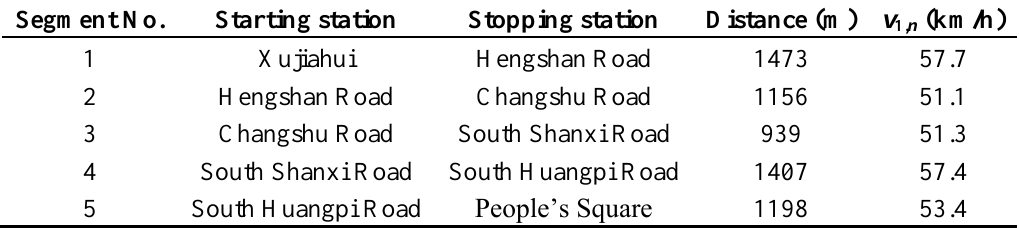
Table 1. The information of the pilot